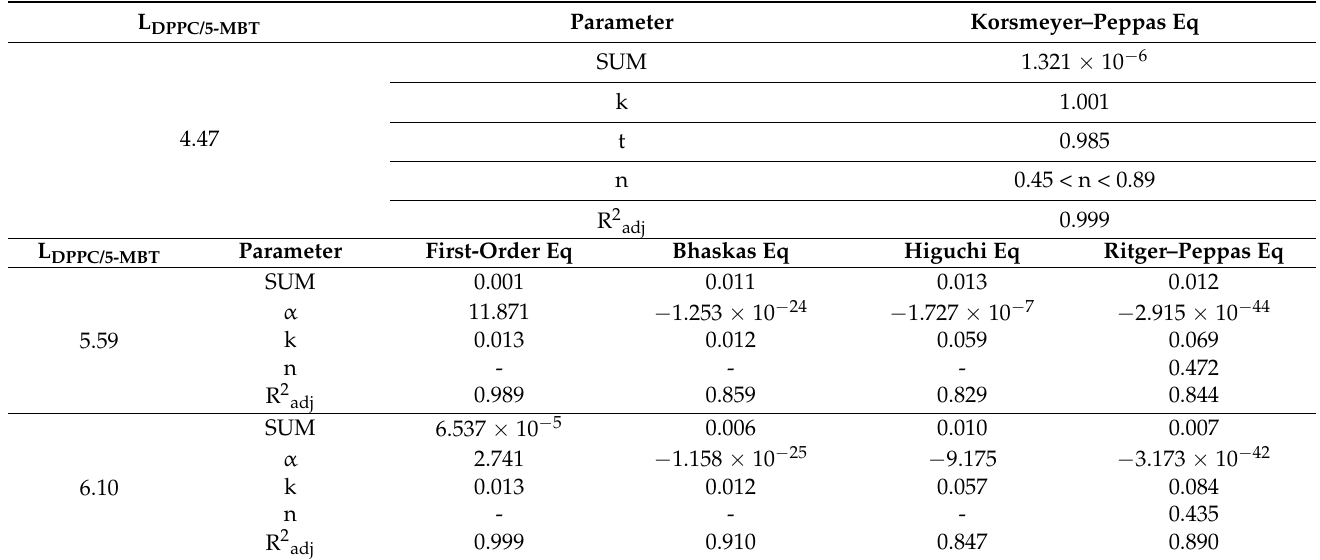
Table 2. Fitting parameters of the 5-MBT release profiles from L DPPC/5-MBT liposomes to different kinetic